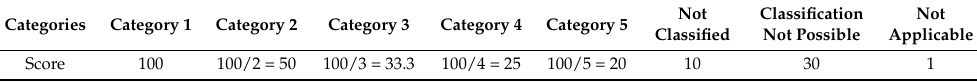
Table 2. The quantification results of health hazard